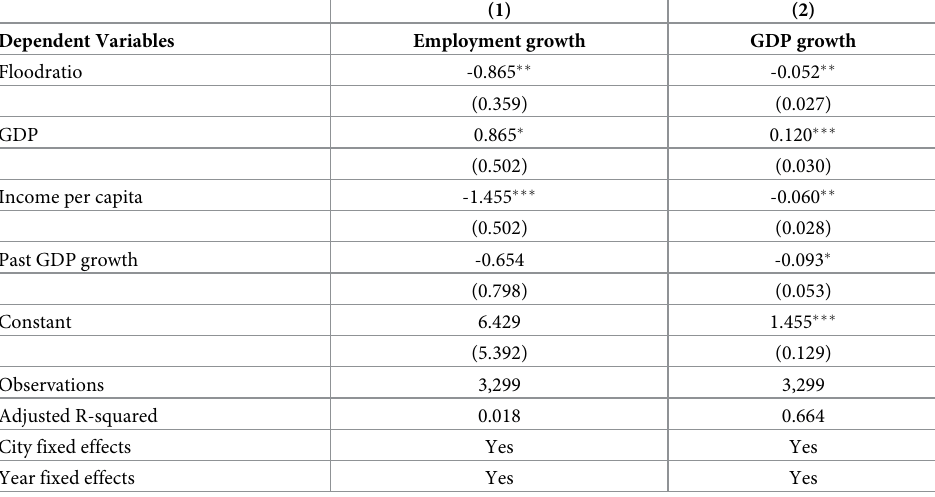
Table 10. Flooding, GDP growth rate, and employee growth: City-level analysis. This table reports the city-level OLS regression results of the effects of flooding on local employee growth and GDP growth. The sample has 3,299 city- year observations, including those cities with at least one listed firm during the period of 2003 to 2019. Dependent vari- ables are employment growth rate and GDP growth rate, both of which are measured at the city level. Other variables are also measured at the city level. Variable definitions are in Table A1 in the S1 Appendix. Robust standard errors are clustered at the city level and reported in parentheses. � , �� and ��� indicate the significance levels at the 10%, 5% and 1%,